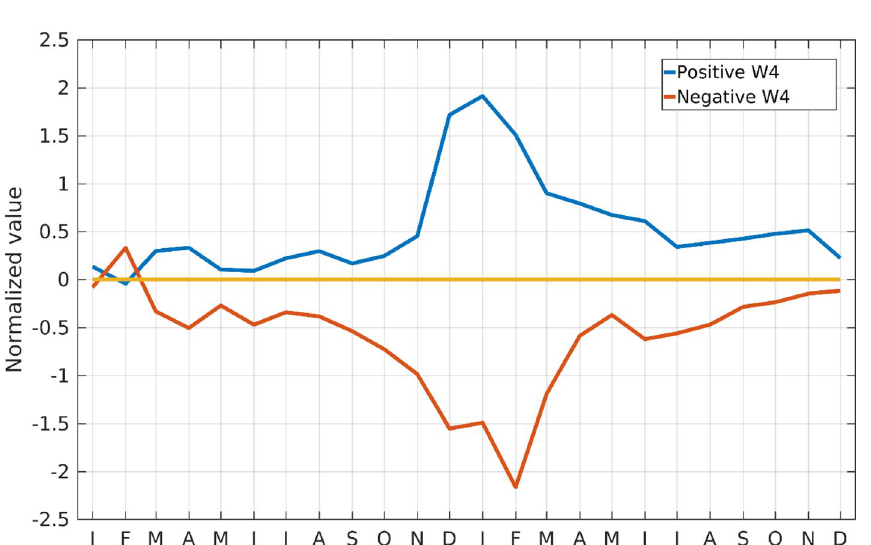
Figure 3. Evolution of the W4 pattern from January of the developing year to the December of the event year. Blue (red) line corresponds to positive (negative) extreme